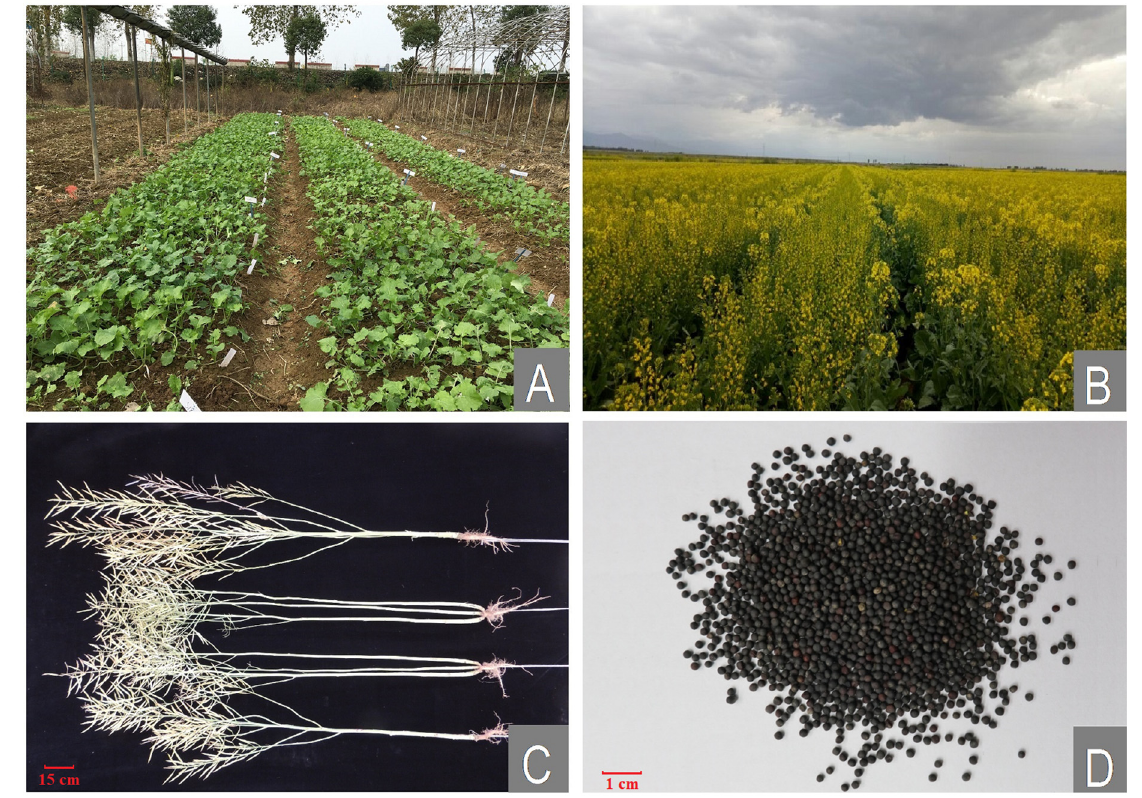
Figure 2. Winter-type rapeseed: ( A ) Field established crop stand at a site in Huanggang, Hubei province (June 2018). ( B ) Blooming field in Xining, Qinghai Province (August 2018). ( C ) Post-harvested and dried stem and siliques. ( D ) Mature seeds.